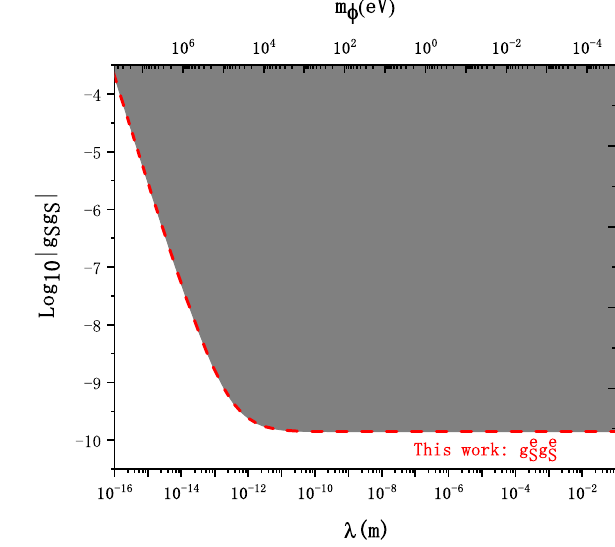
| a function g e S S